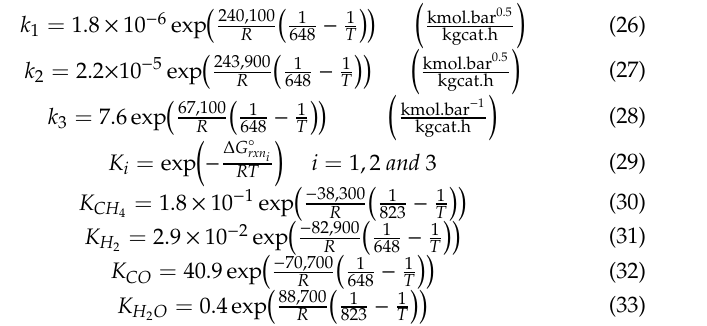
Table 2. Thermodynamic and rate constants for Equations (23)–(25) are taken from Xu and Froment [32]. (cid:16) 240,100 k 1 = 1.8 × 10 − 6 exp R